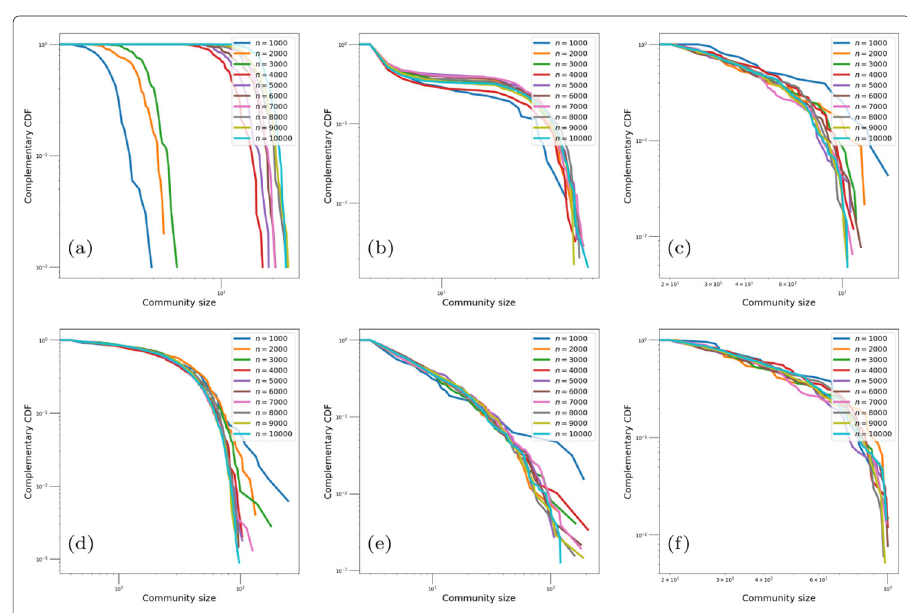
Fig. 21 Variation of the number of nodes ( n ) for LFR synthetic networks considering the community size: a Bigclam; b CFinder; c Copra; d Demon; e SLPA; f Ground-Truth